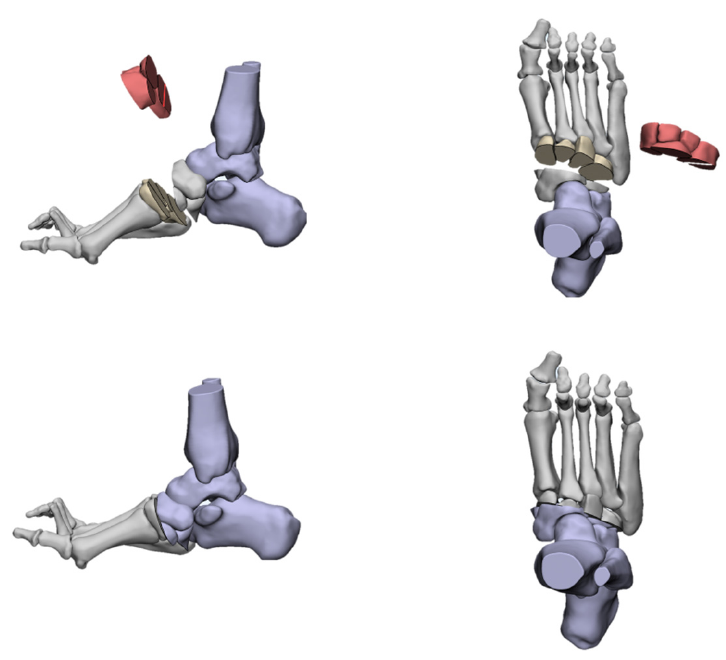
Figure 13. The Akron Osteotomy.